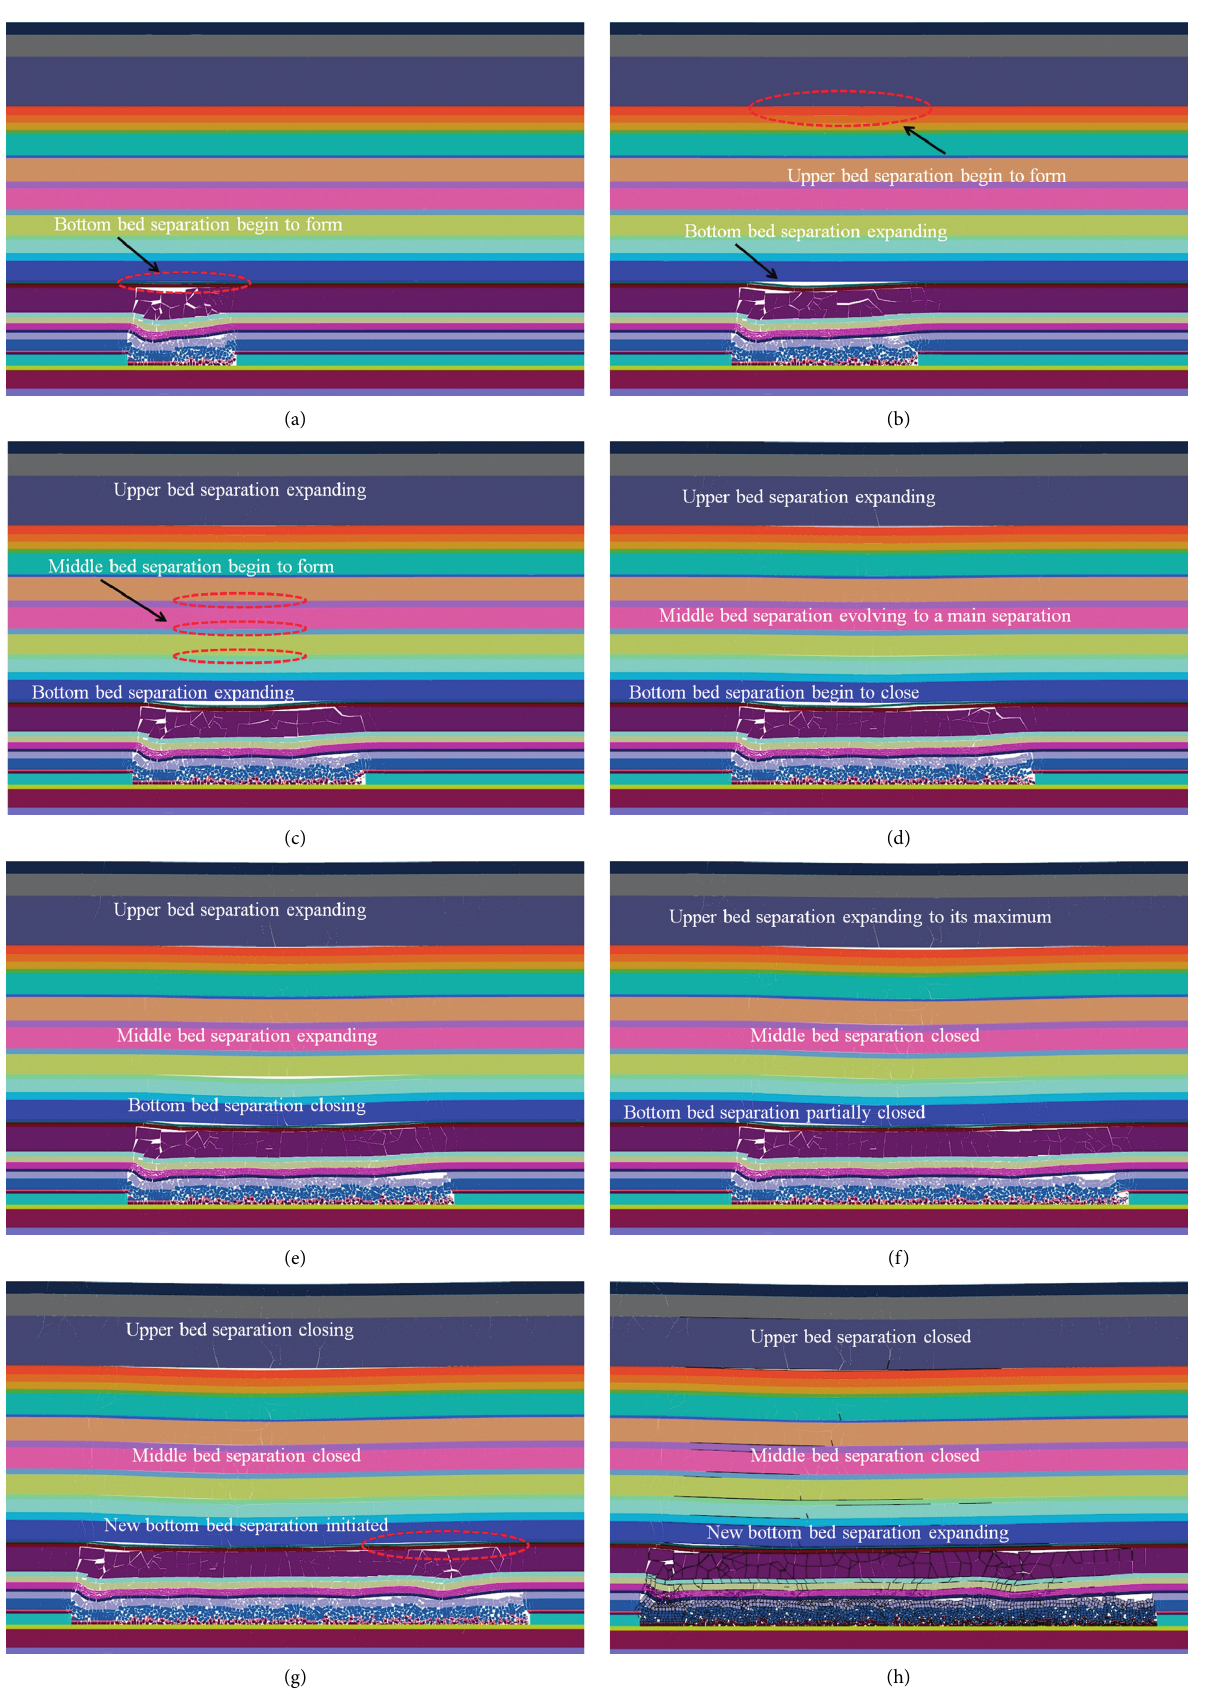
Figure 7: Evolution of bed separation in the overburden of the 4203 LTCC panel. The longwall face advancing (a) 70m, (b) 120m, (c) 150m, (d) 190m, (e) 210m, (f) 255m, (g) 295 m, and (h)